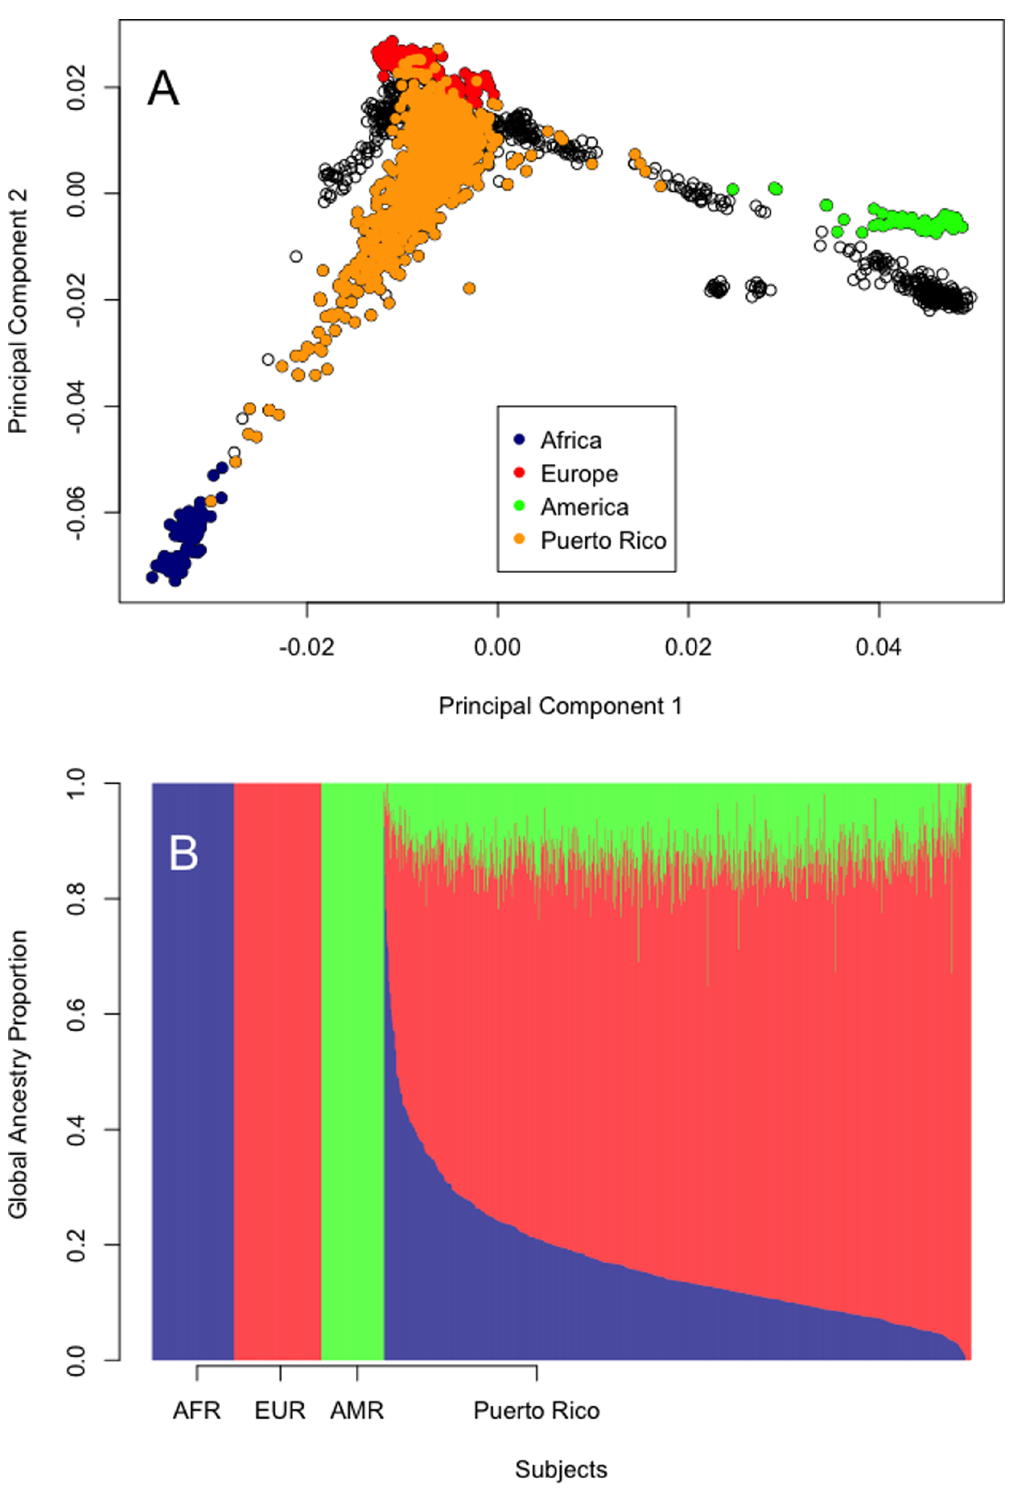
Figure 1. ‘‘Global’’ continental ancestry in Puerto Rican subjects. A. Principal components analysis of the combined Puerto Rican and HGDP subjects. B. ‘‘Global’’ continental ancestry was estimated using Admixture 1.2 in an analysis supervised by data from HGDP populations as described in Methods (AFR, sub-Saharan African continent, dark blue; EUR, European continent, red; and AMR, Mexico, Central and South America continents, green). HGDP subjects not originating from these three continents are black. Puerto Rican subjects were sorted left-to-right based on ancestry from the African continent.